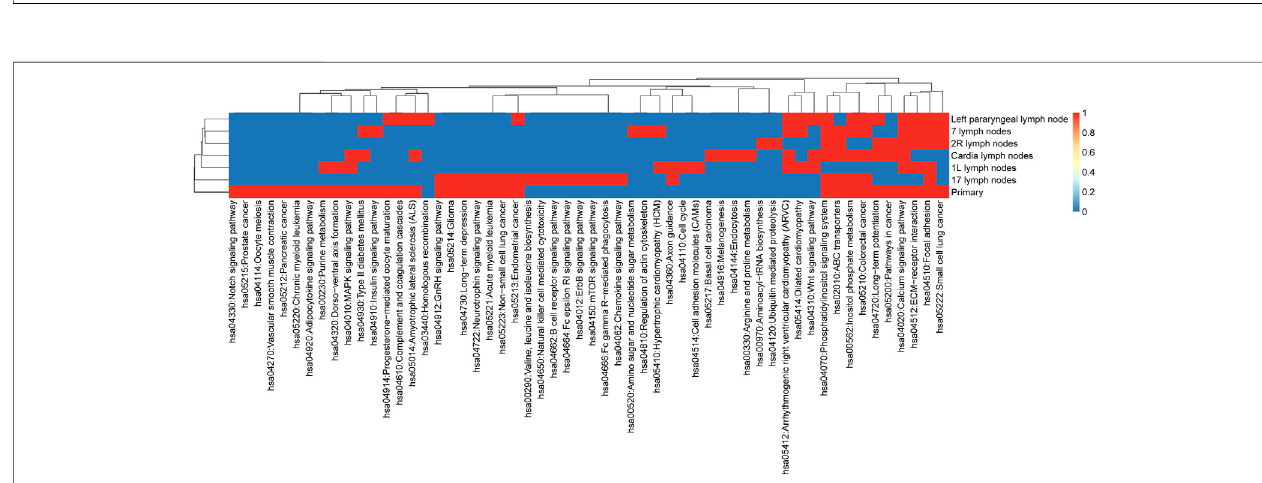
FIGURE 3 | KEGG pathway enrichment in multi-region of primary and metastatic